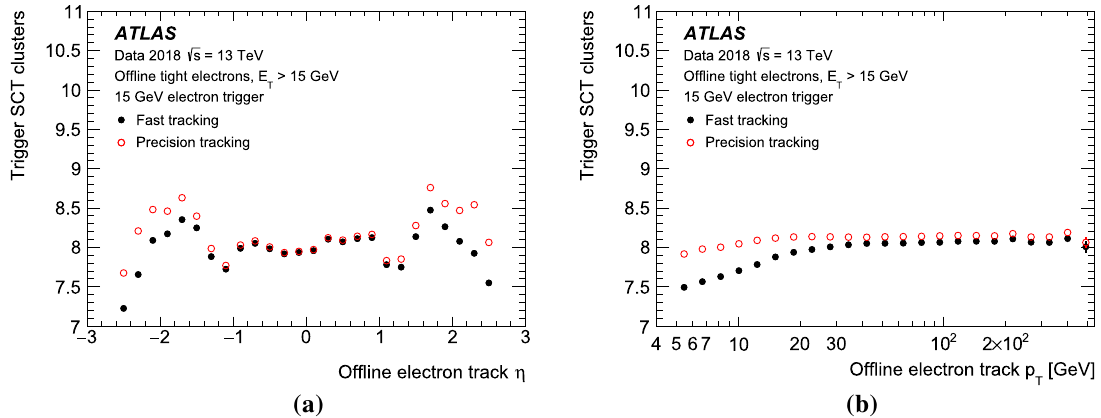
Fig. 30 The SCT cluster multiplicity for the trigger tracks matched to offline electron candidate tracks as a function of a the offline electron candidate pseudorapidity and b the offline electron candidate transverse momentum from the dilepton performance trigger